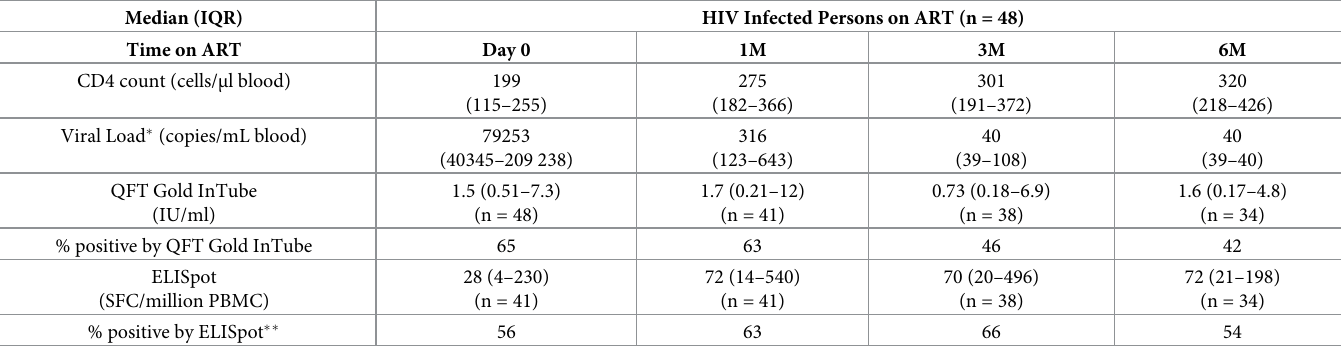
Table 1. Effect of ART on CD4 counts and Viral loads of patients longitudinally, and sensitisation to Mtb as determined by interferon gamma release assays. Median (IQR) HIV Infected Persons on ART (n = 48) Time on ART Day